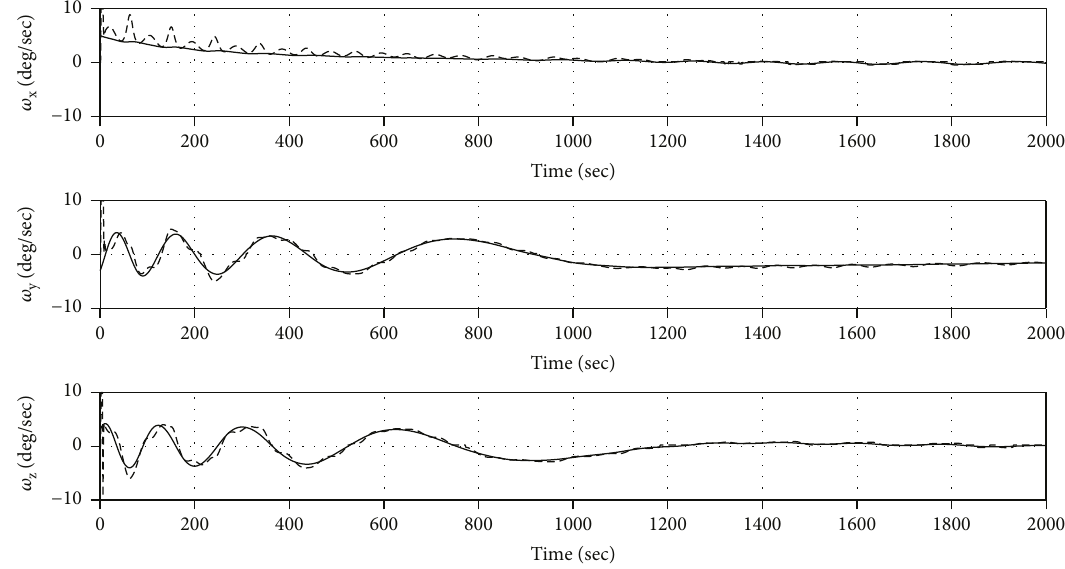
ω ω x , y , and z ) during Tigrisat detumbling.